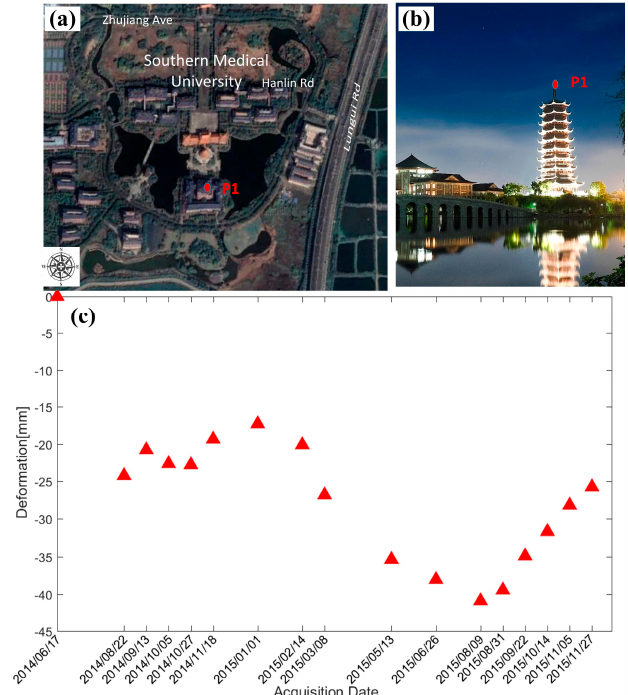
Figure 21. Time series analysis on point P1 (referenced to 2014/06/17): ( a ) the location of P1 on Google earth optical image; ( b ) in-situ picture (download online) of location P1; ( c ) time series deformation evolution over